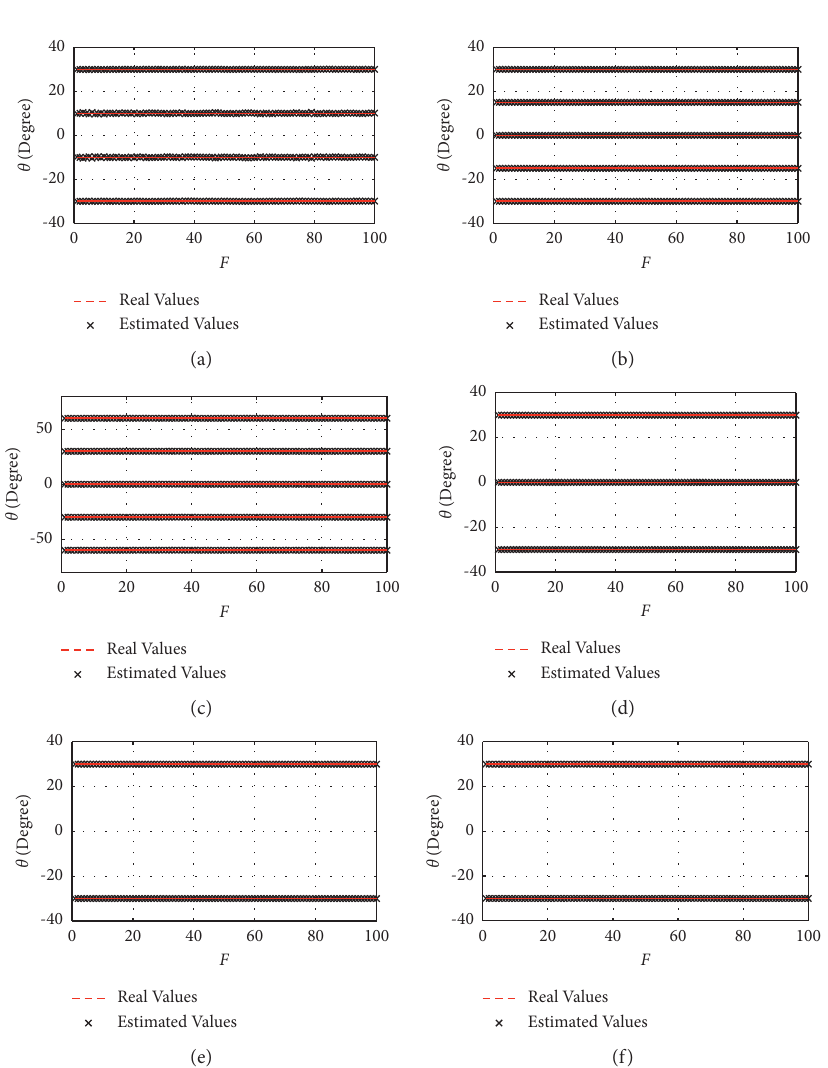
Figure 4: The estimation values of coherent signals in different sparse arrays.